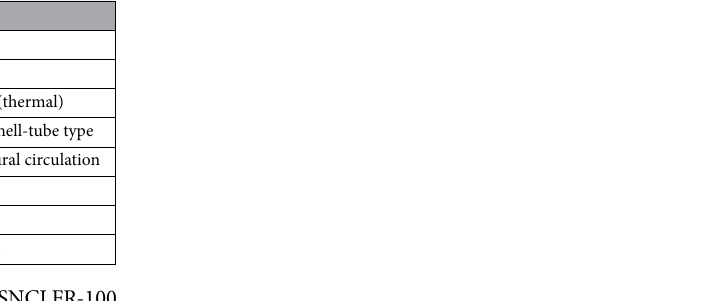
Table 1. Major parameters of